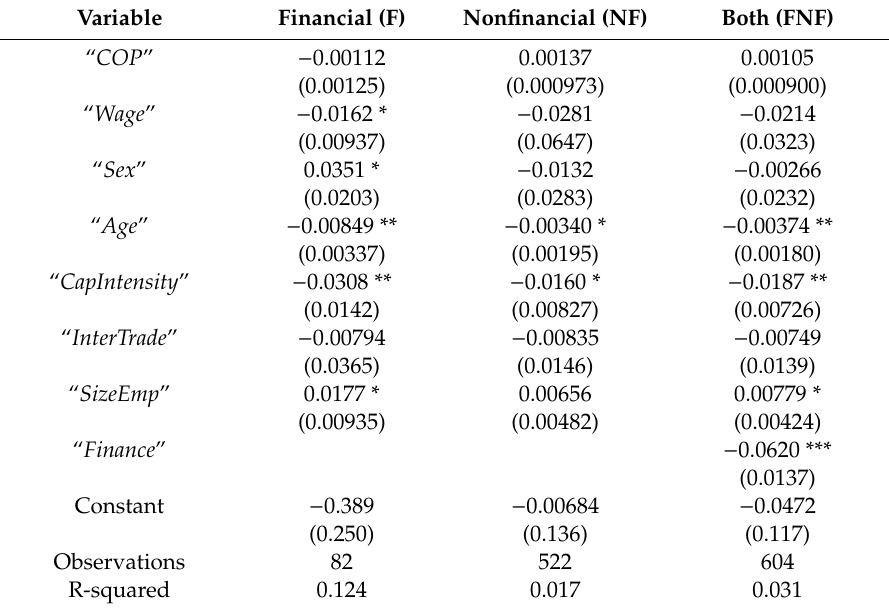
Table A2. Correlates of ROE for financial and nonfinancial firms.